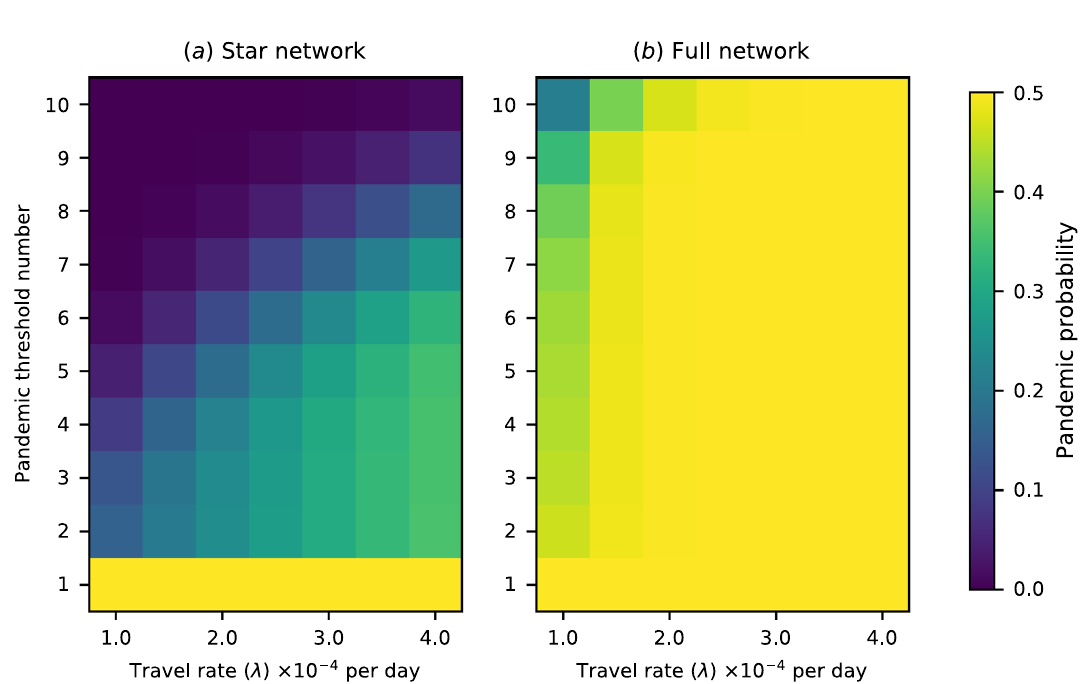
Figure 2. Pandemic probability for a range of between-region travel rates and a range of transregional pandemic definitions. The “pandemic threshold number” refers to the minimum number of regions that must experience epidemics before a pandemic is declared. The pandemic probability is, in general, sensitive to the pandemic definition used, but the degree of sensitivity depends on network structure and travel rates. ( a ) Pandemic probability for a star network. The pandemic probability is, in general, highly sensitive to the pandemic definition used. ( b ) Pandemic probability for a fully connected network. The sensitivity of the pandemic probability to the pandemic definition used is significantly reduced at high travel